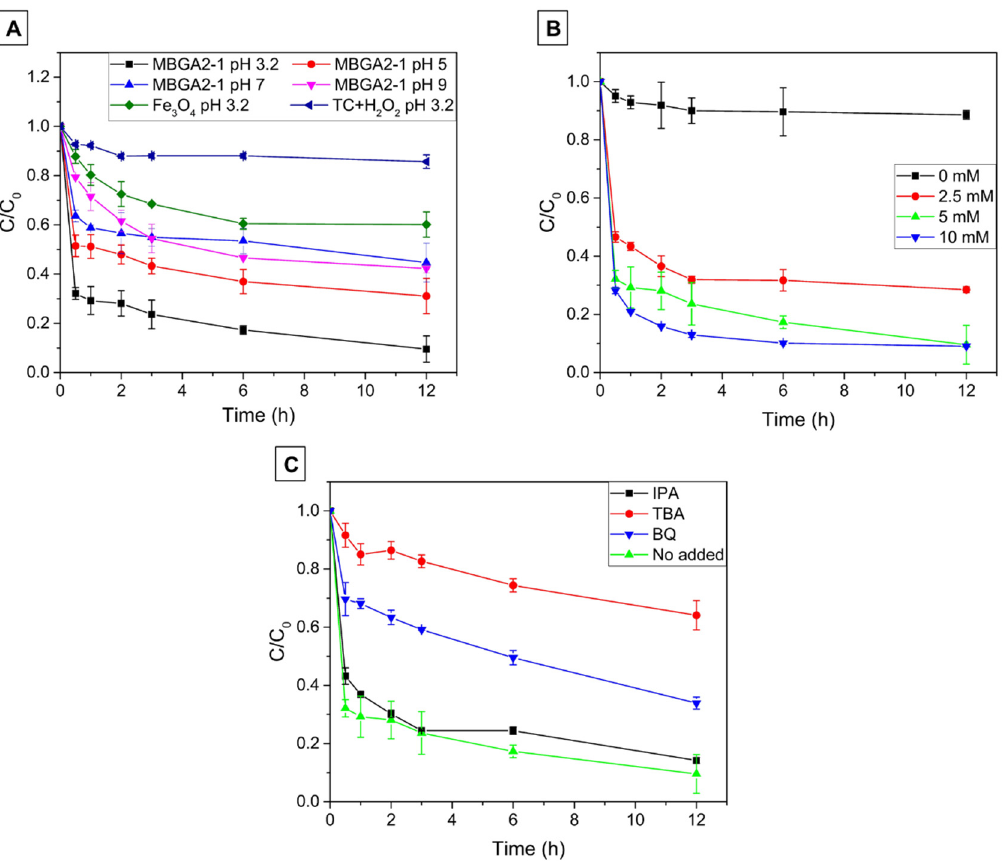
Figure 4. The catalytic degradation of TC ( A ) Effect of pH ( B ) Effect of H 2 O 2 concentration ( C ) Effect of scavenger (conditions: C 0 = 800 mg/L, pH 3.2 (natural), H 2 O 2 concentration = 5 mM, catalyst concentration = 1 g/L, T = 28 ± 2 °C).